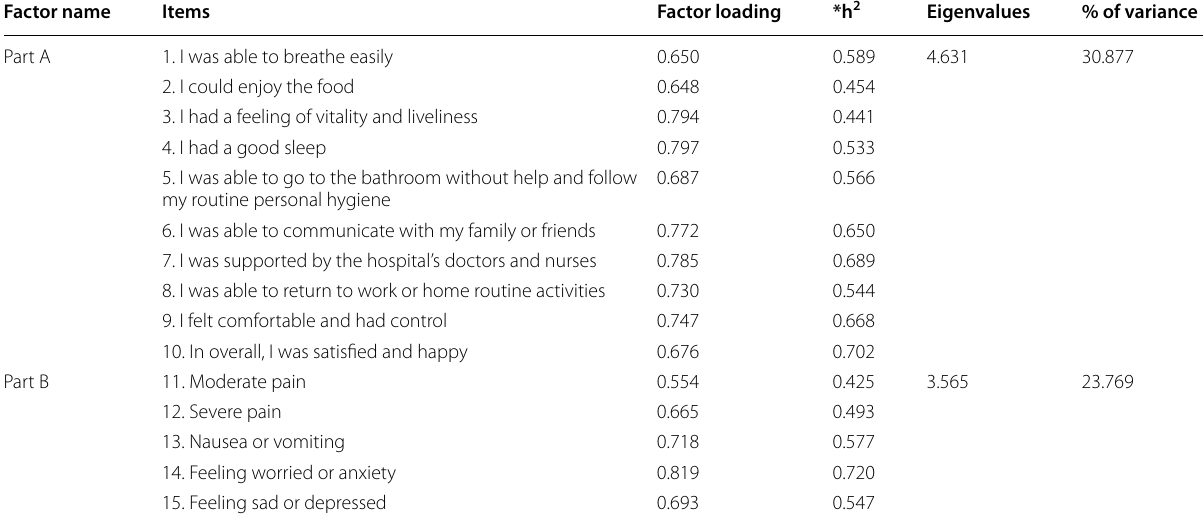
Table 3 Exploratory factors extracted from the QoR-15